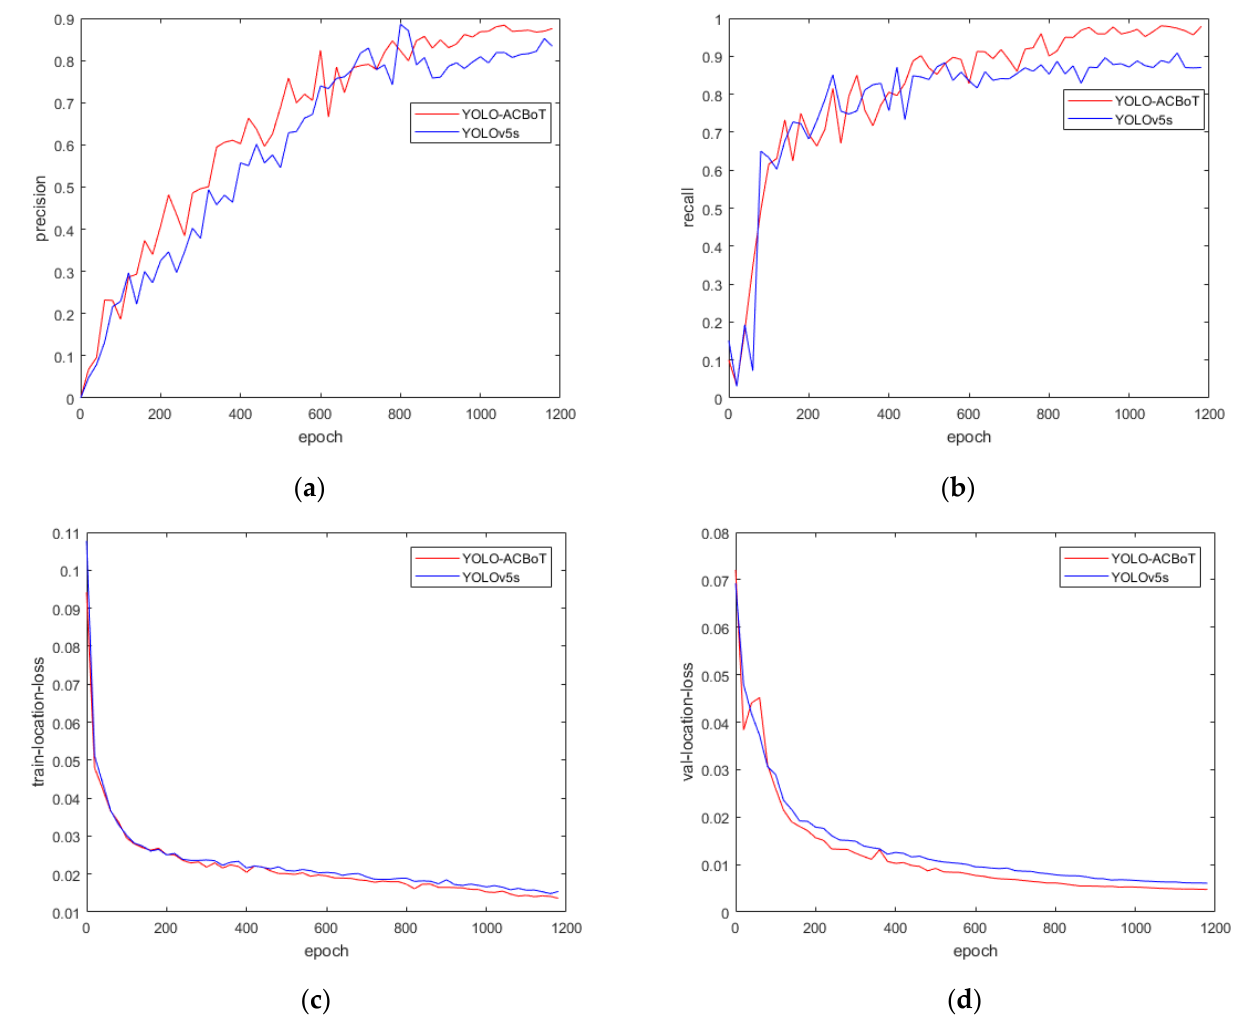
Figure 9. Four performance curves. ( a ) precision; ( b ) recall; ( c ) train-location-loss; ( d ) validation- location-loss.